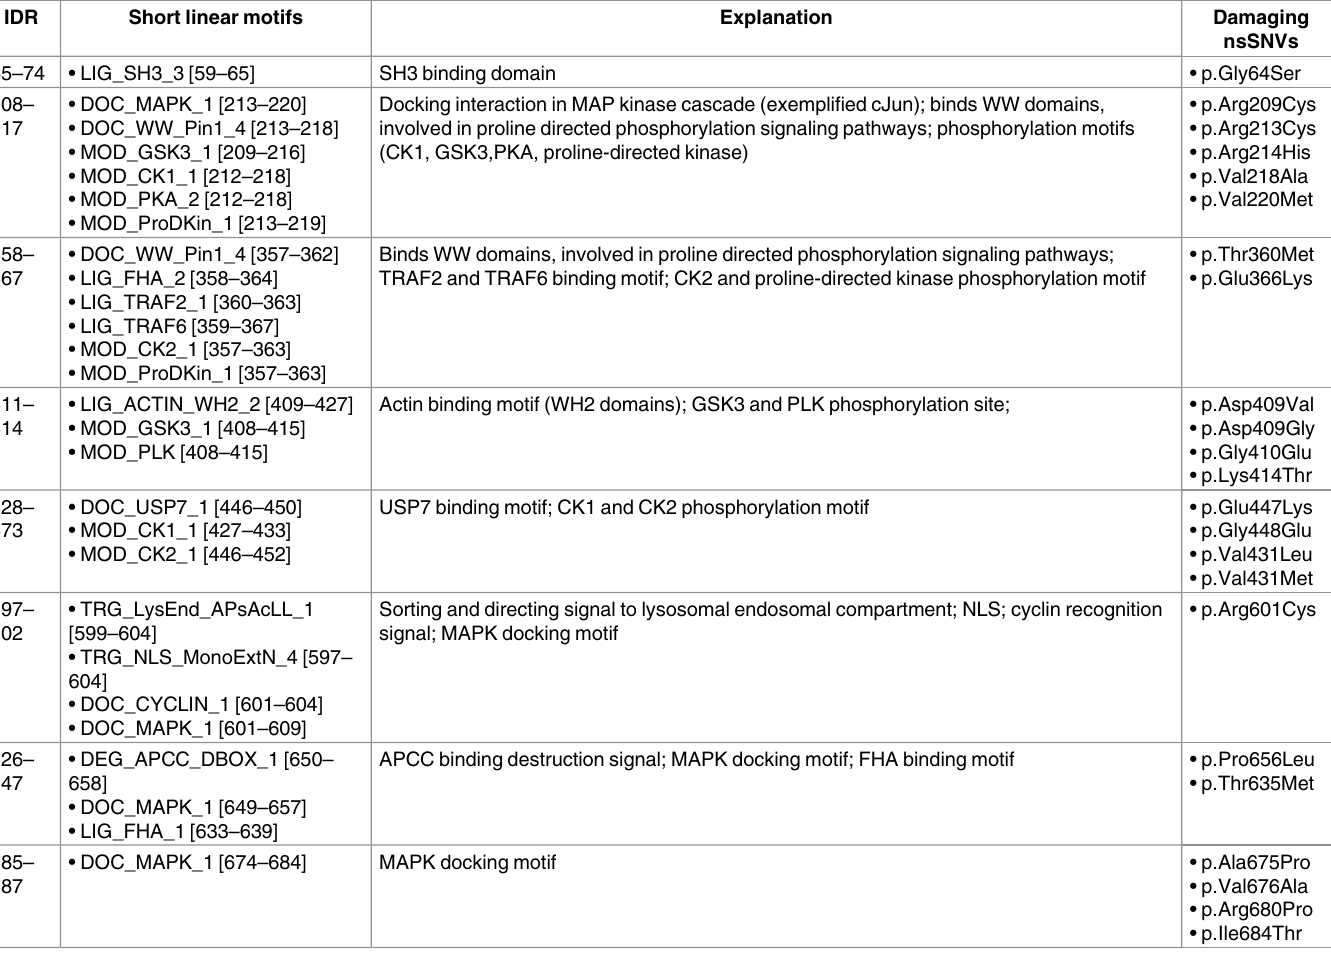
Column 1 indicates the position of IDRs; column 2 shows the names of SLiMs and their coordinates in square brackets; column 3 provides explanation for the function of the given SLiM; column 4 lists damaging nsSNVs in